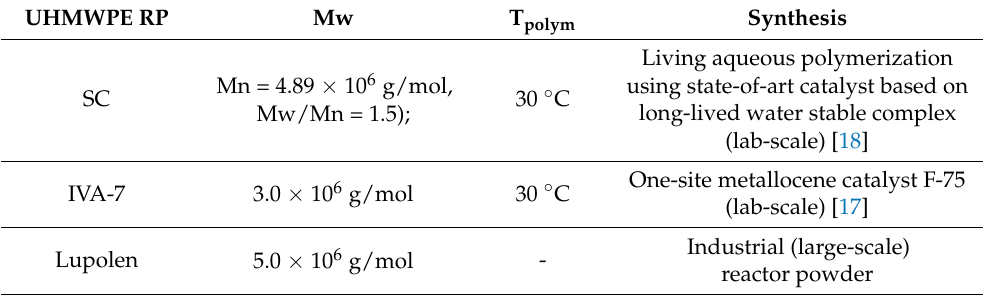
Table 1. Characteristics of the investigated UHMWPE reactor